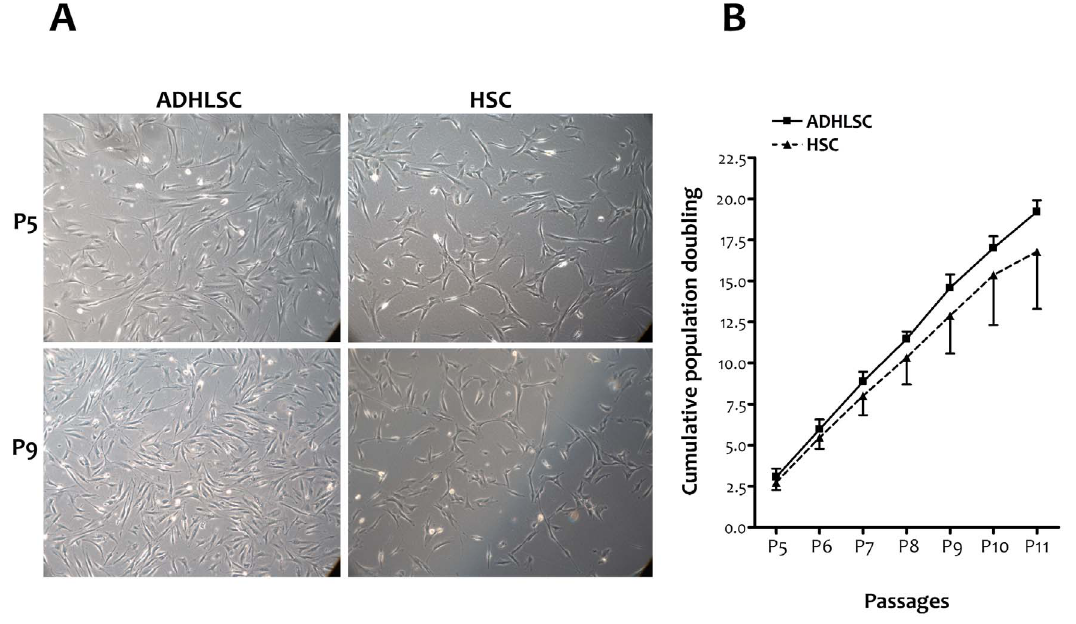
Figure 1. ADHLSC and HSC in culture. A , Fibroblastic morphology at passages 5 & 9 as shown using phase contrast microscopy, original magnification 100 6 . B , Cumulative population doubling of both cell types from passage 5 to passage 11